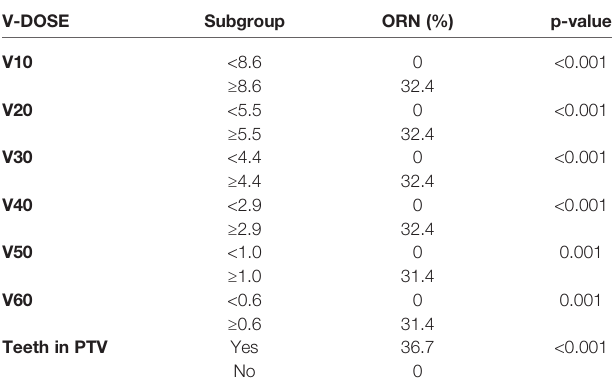
TABLE 3 | Univariate analysis of dichotomized dosimetric factors from LEM- based calculated treatment plans to assess dose-volume relationship and risk of maxillary